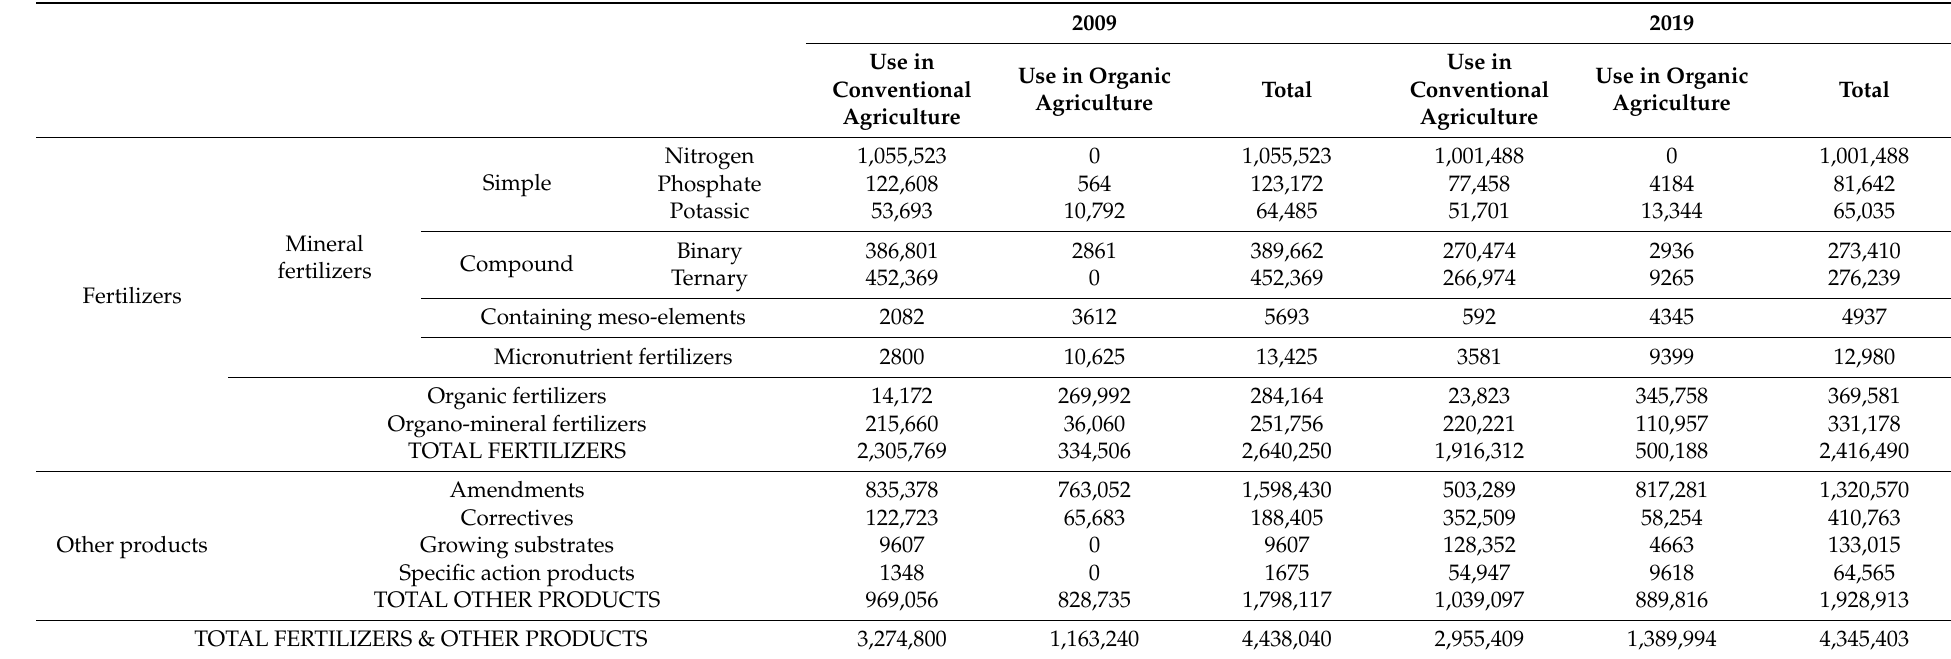
(Data source: Italian National Institute of Statistics,